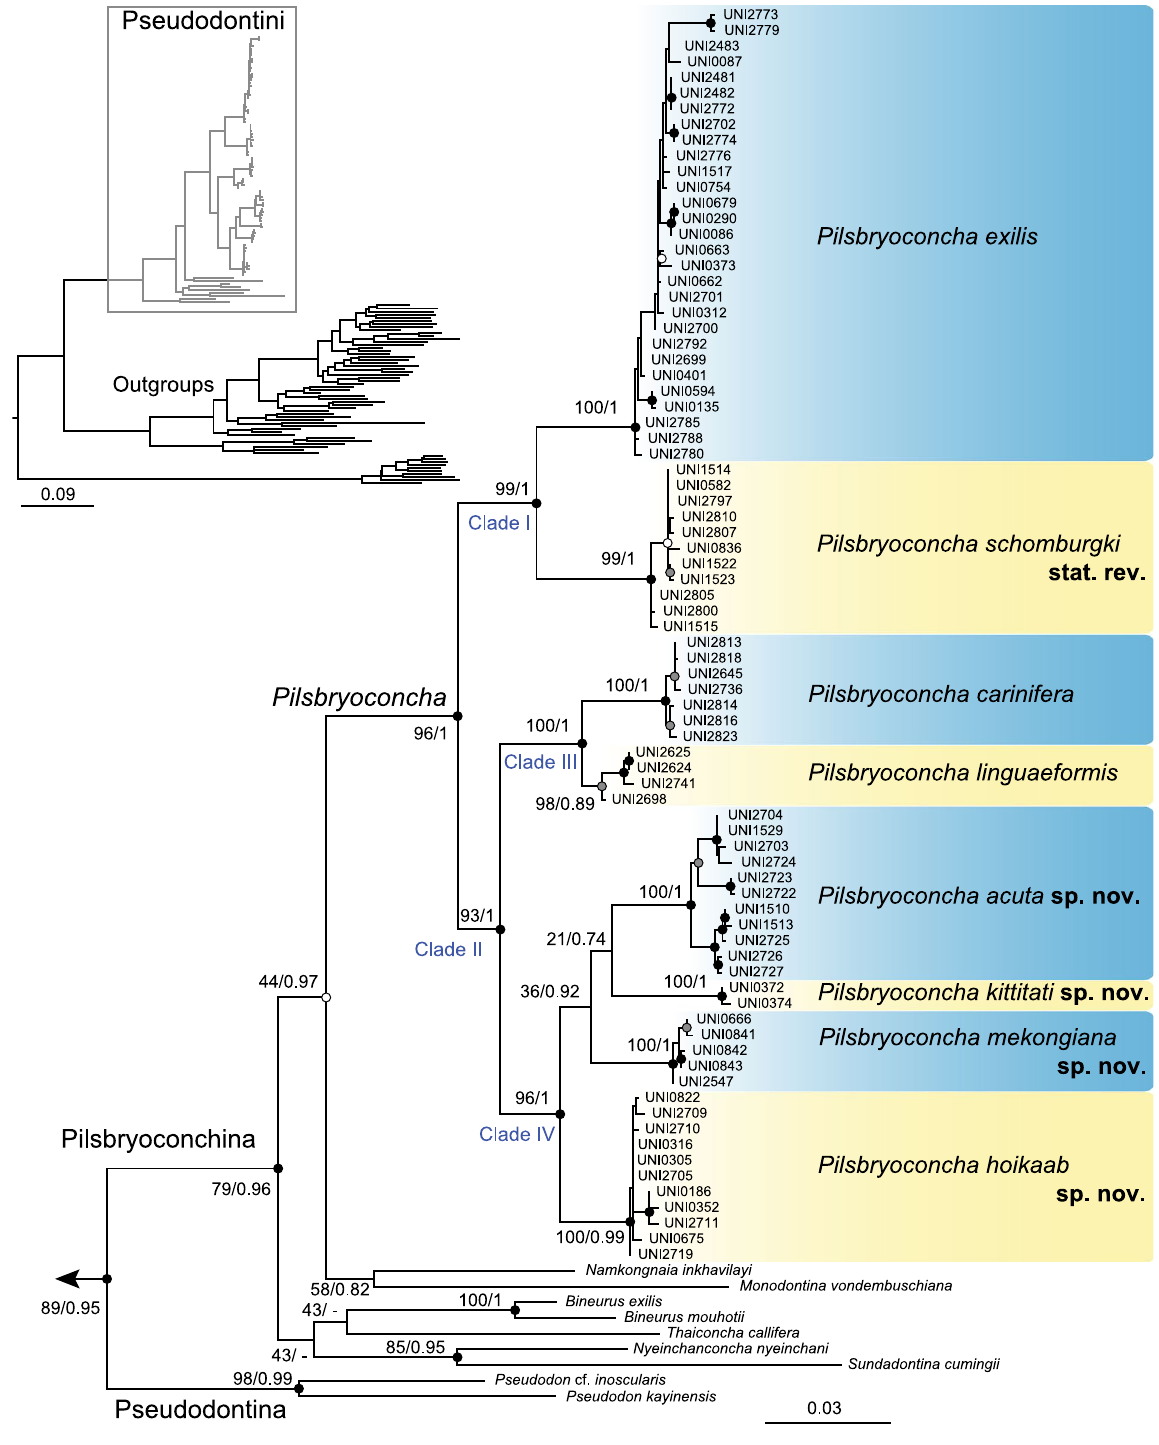
Figure 1. Maximum likelihood tree based on 2216 bp concatenated alignment dataset of COI + 16S + 28S genes. The outgroup sample is not shown. Numbers on nodes indicate bootstrap values (bs) from maximum likelihood (ML) and bipartition posterior probability (bpp) from Bayesian inference analysis (BI), and are shown as ML/ BI. Nodes marked with black circles were sufficiently supported by both ML (bs ≥ 70) and BI (bpp ≥ 0.95). Nodes with grey circles were supported only by ML, and white circles were supported only by